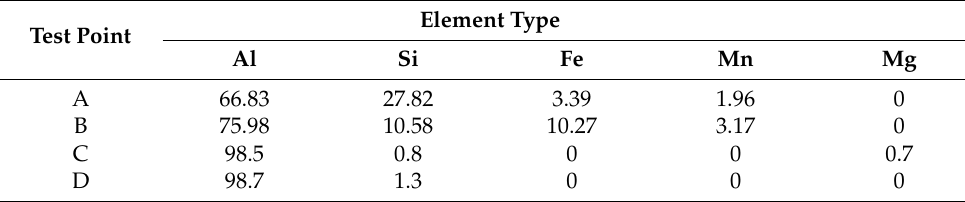
Figure 11. SEM images of the PM brazed seam interface and corresponding element mapping: ( a ) Microstructure of 6061 base material—brazed seam; ( b ) Al; ( c ) Si; ( d ) Mg; ( e ) Fe; ( f ) Microstructure of brazed seam—3003 base material; ( g ) Al; ( h ) Si; ( i ) Mn; ( j ) Fe. Table 2. The chemical composition of each point in Figure 10